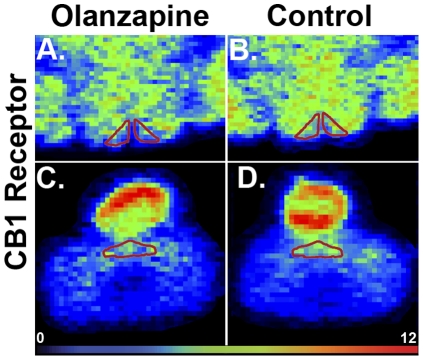
Example of CB1R Binding Density Following Olanzapine Treatment.Example of cannabinoid CB1 receptor binding density (using [3H]SR-141716A) in the A, C: hypothalamic arcuate nucleus and B, D: dorsal vagal complex of the caudal brainstem of female Sprague Dawley rats following A, B: 2.0 mg/kg olanzapine treatment, C, D: vehicle (control) for 14-days (t.i.d.). Autoradiographs are examples of raw data used for the graphs depicted in Figure 3D and are average representations of 6 rats per treatment group.